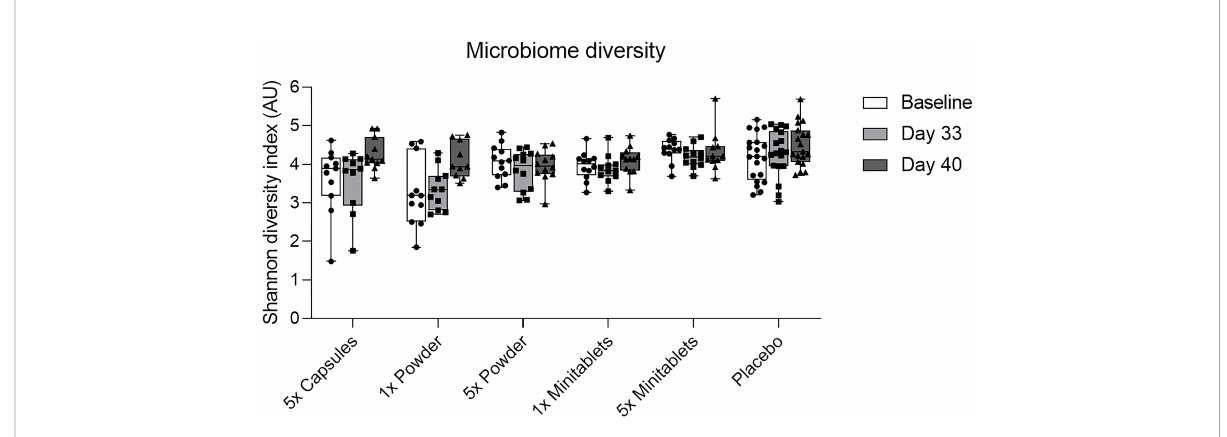
FIGURE 6 Fecal microbiome diversity calculated using the Shannon diversity index by treatment group per time point. Data are shown as median with interquartile range. AU, arbitrary